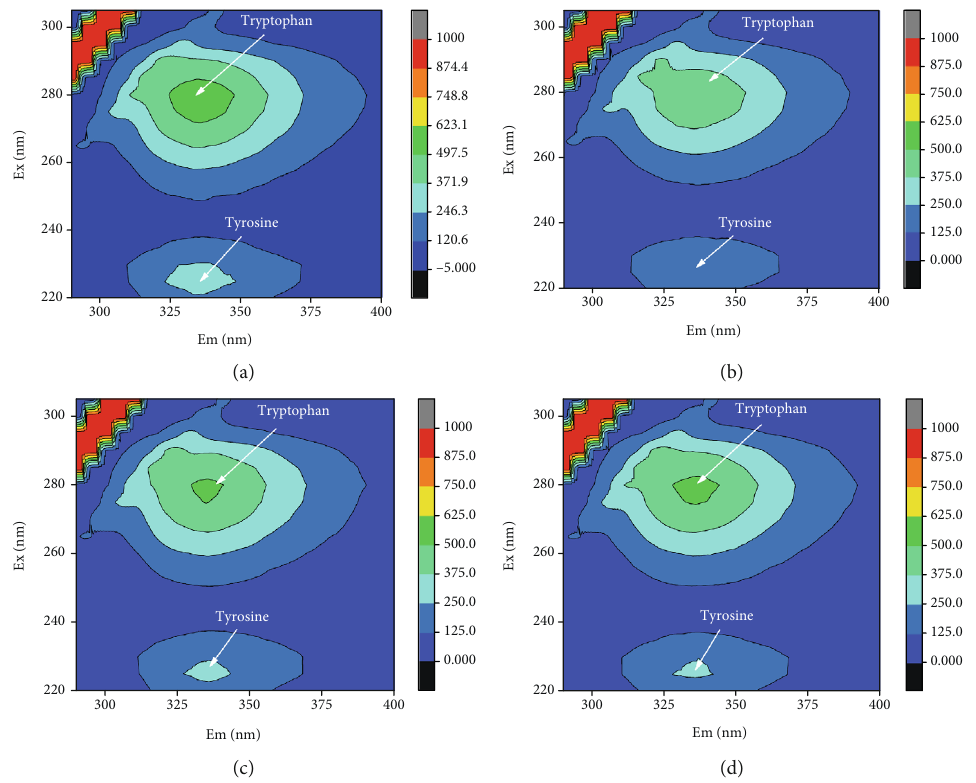
Figure 4: 3D-EEM spectrum of EPS (a) before adsorption, and after adsorption of (b) Pb 2+ , (c) Cd 2+ , (d) Ni 2+